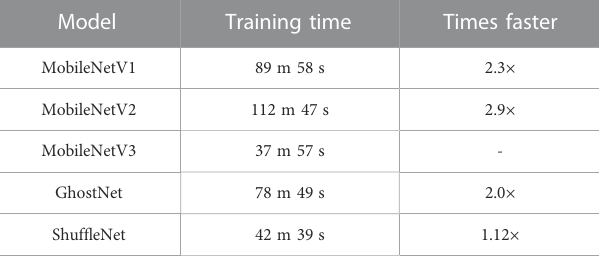
TABLE 1 Training time over the COVID-19 Radiography